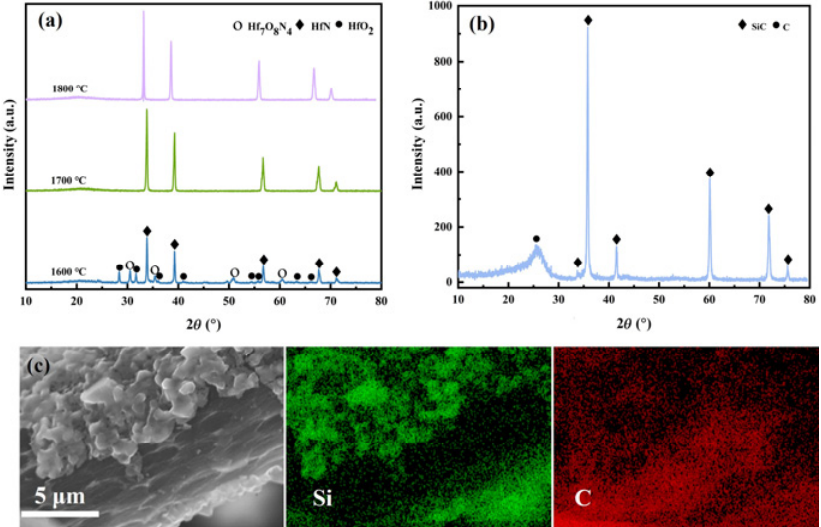
Fig. 8 XRD patterns of (a) HfO 2 and Si 3 N 4 sintered at different temperatures and (b) C reacting with SiO to form SiC; (c) SEM images of C with